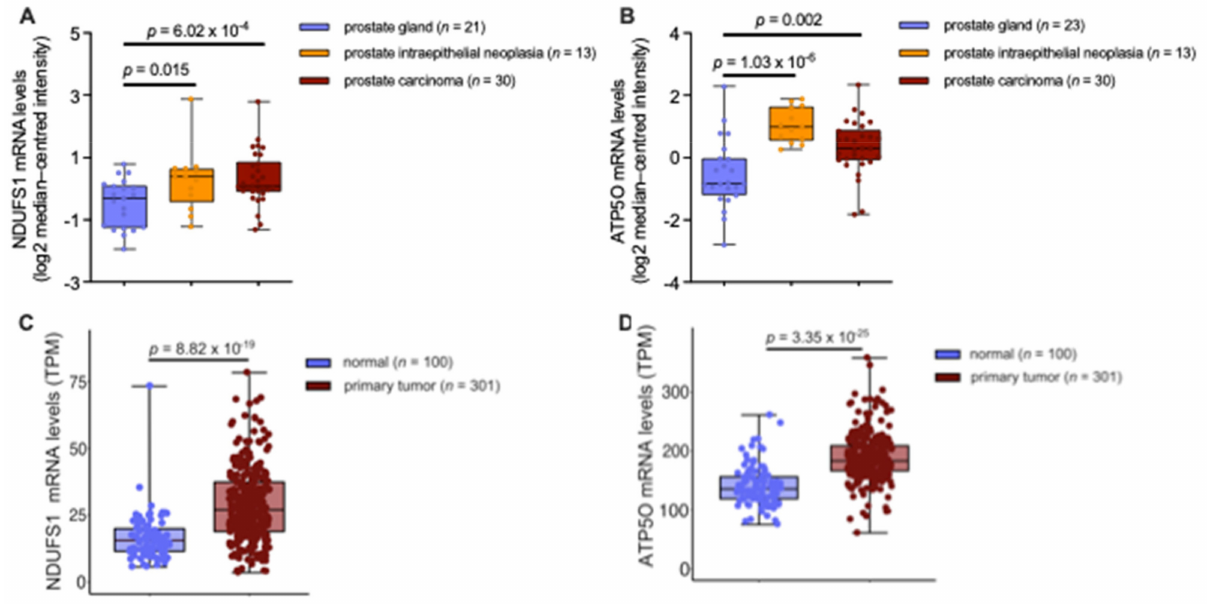
Figure 5. ( A ) NDUFS1 mRNA expression levels analyzed from prostate carcinoma epithelia ( n = 30; 1.74-fold increase), prostatic intraepithelial neoplasia epithelia ( n = 13; 1.69-fold increase), or normal prostate gland samples ( n = 21). ( B ) ATP5O mRNA expression levels analyzed from prostate carcinoma epithelia ( n = 30; 1.83-fold increase), prostatic intraepithelial neoplasia epithelia ( n = 13; 3.01-fold increase), or normal prostate gland samples ( n = 23). ( C ) NDUFS1 mRNA expression levels (TPM) analyzed from TCGA-PRAD primary tumor tissue ( n = 301) and true normal tissue samples (cancer-free patients) from GTEx ( n = 100). ( D ) ATP5O mRNA expression levels (TPM) analyzed from TCGA-PRAD primary tumor tissue ( n = 301) and true normal tissue samples (cancer-free patients) from GTEx ( n = 100). Data for ( A,B ) were extracted from the Oncomine™ Platform from the Tomlins Prostate dataset. Data for ( C – D ) were extracted from The Cancer Genome Atlas-Prostate Adenocarcinoma data collection and the Genotype-Tissue Expression project. Representation: boxes as interquartile range, horizontal line as the mean, whiskers as lower and upper